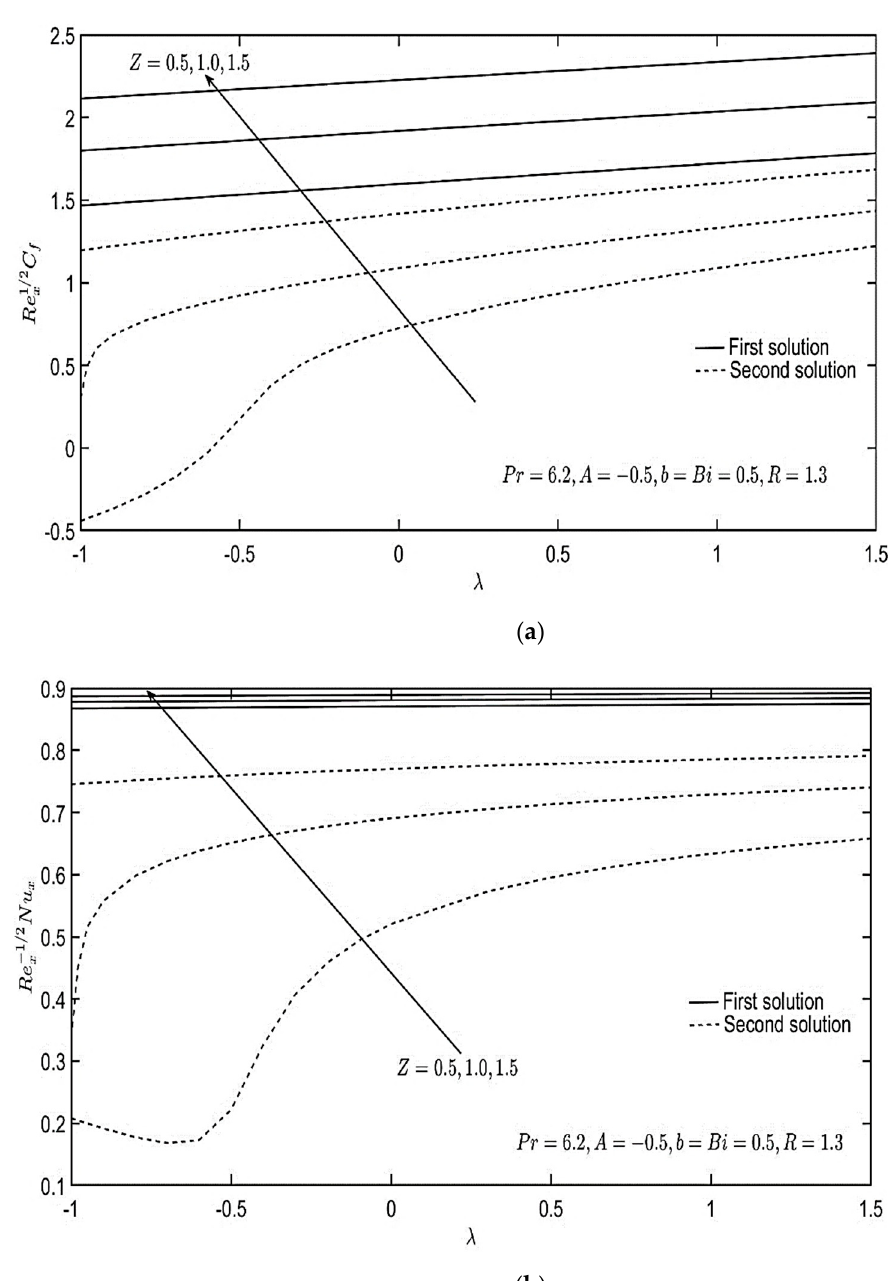
− 1/2 x C f and ( b ) Re x Nu x with various values of Z and λ